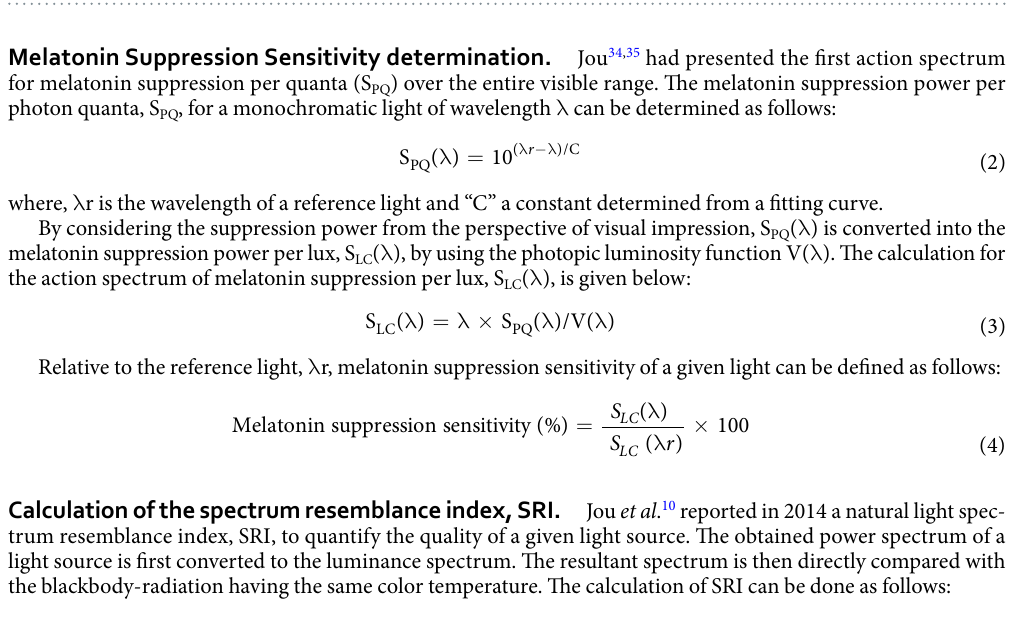
Figure 1. Schematic energy-level diagrams of the studied OLED devices. ( a ) Device with four different white- light complementary emitters, ( b ) devices with the incorporation of a co-host TCTA, and ( c ) devices with a hole-transport